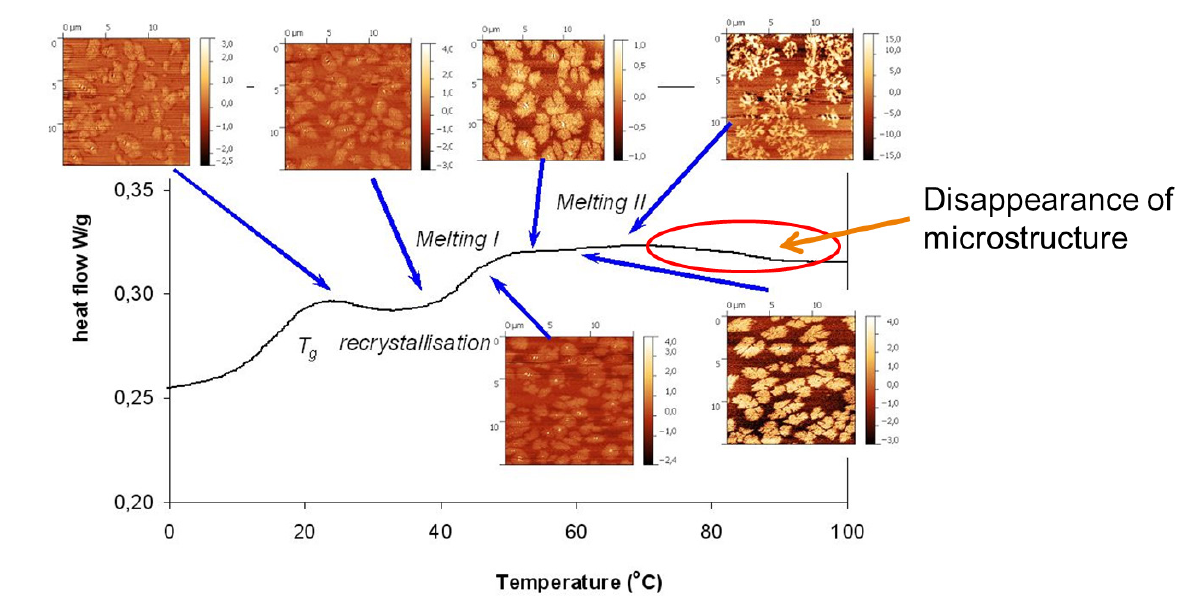
Figure 1. Microstructural changes with increasing temperature